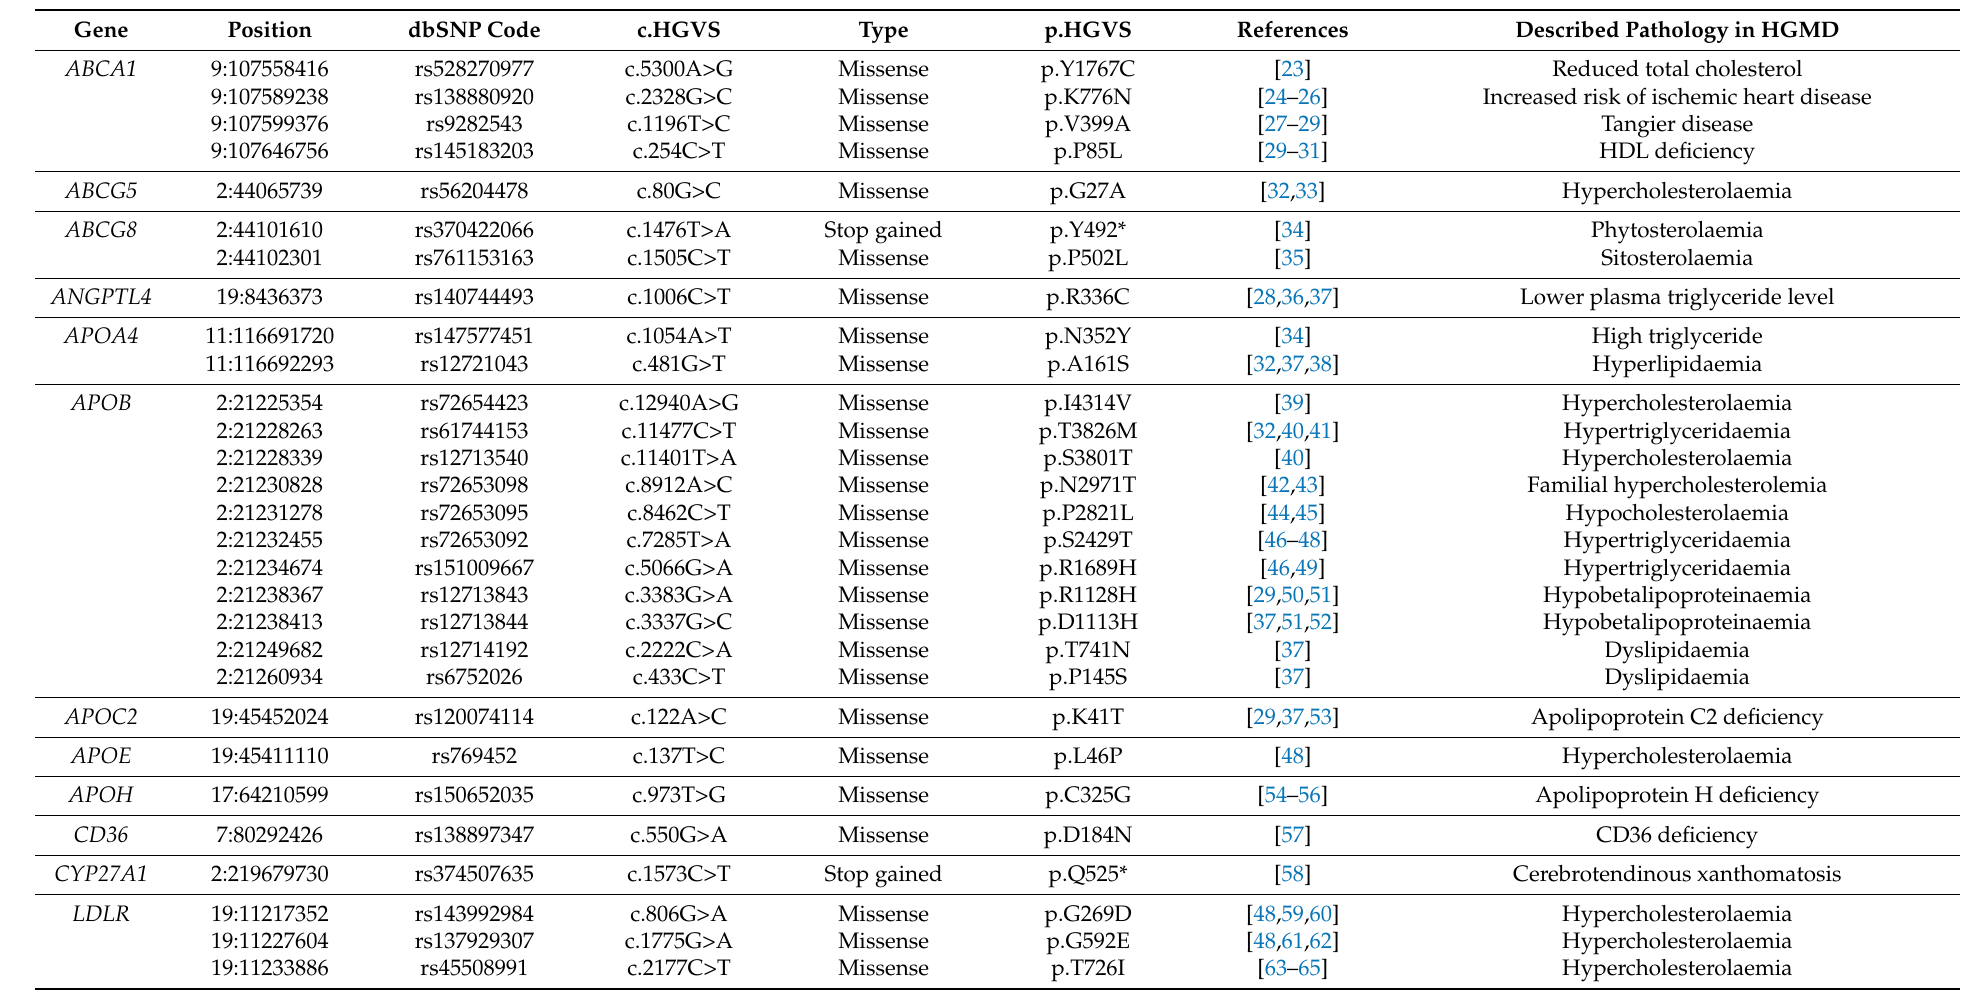
Table 2. Category Ip (known